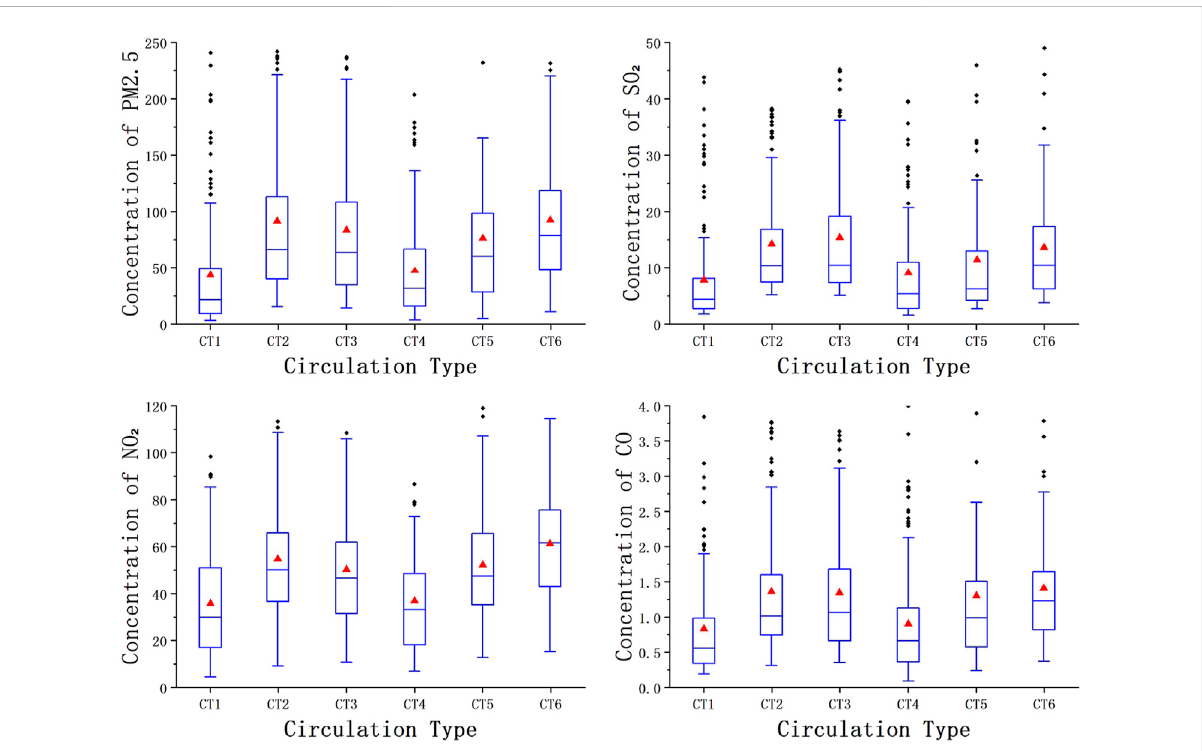
FIGURE 4 Concentration distributions of PM 2.5 , NO 2 , SO 2 , and CO under the six circulation patterns in Beijing from 2014 to 2022. The red triangles represent mean values. The bottoms and tops of the lines represent the values of the 5th and 95th percentiles, respectively; the lower sides of the rectangle represent the 25th percentile, the middle line represents the median, and the top lines represents the 75th percentile. The black dots represent the discrete values which are considered outliers to the